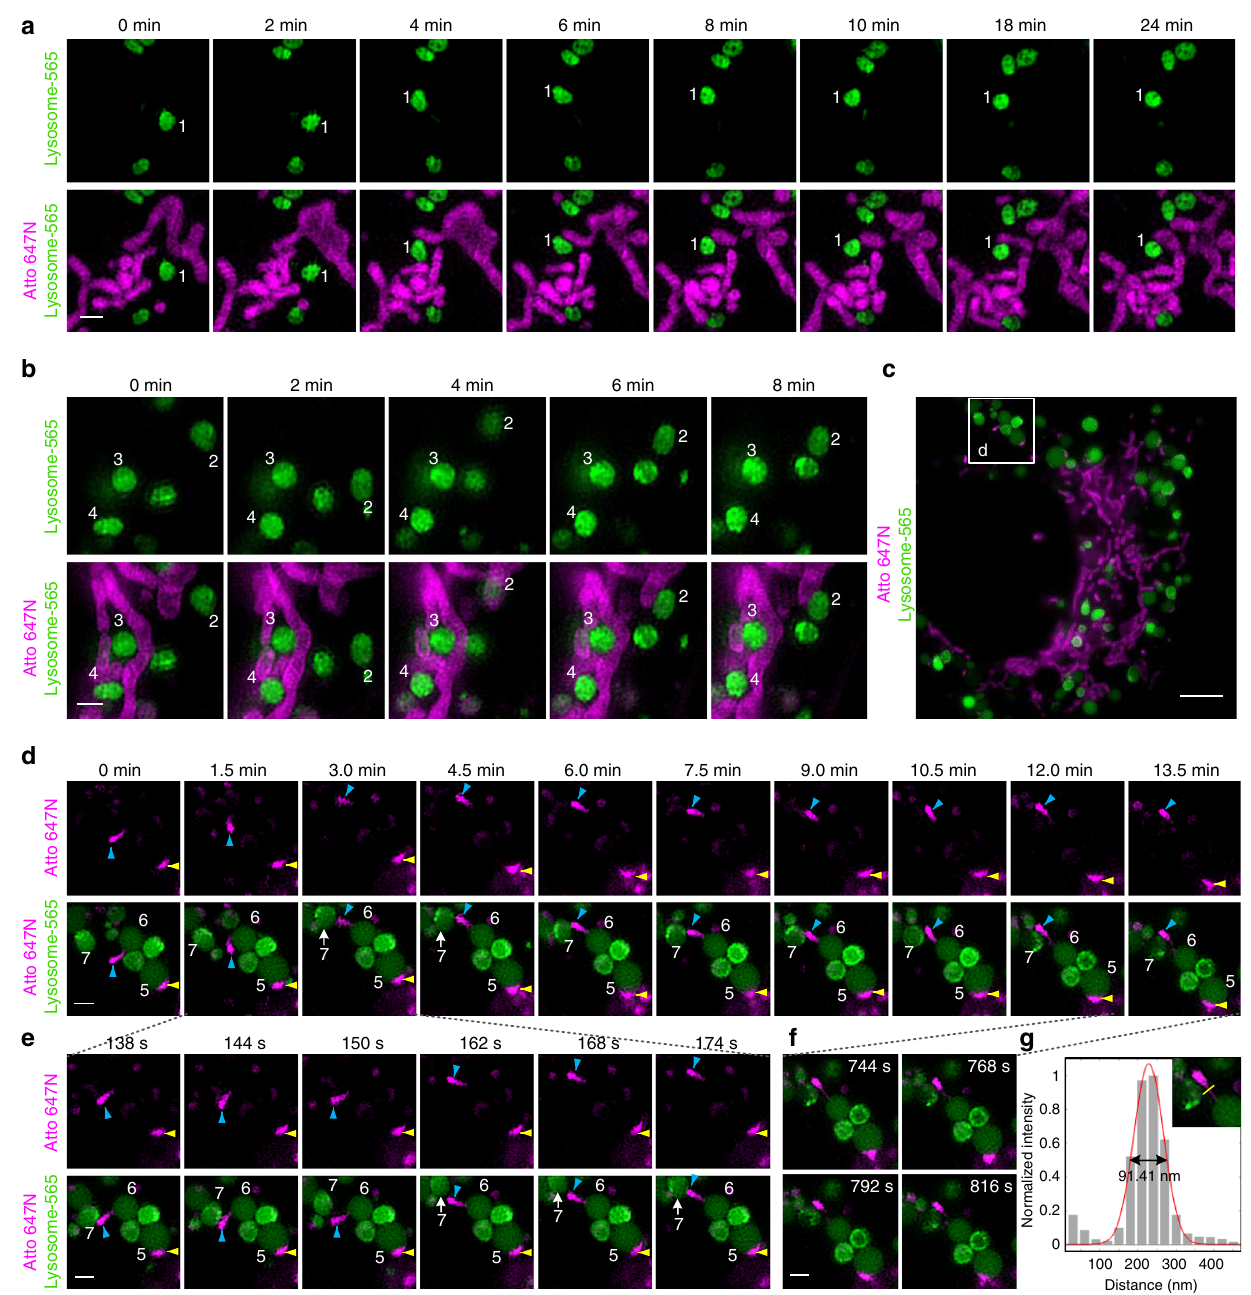
Fig. 3 Dual-color SIM images of lysosomes and mitochondria in live cells. a , b , d , e , f Representative time-lapse SIM images reveal different types of dynamic physical interactions between lysosomes and mitochondria in live U2OS cells stained with Lysosome-565 (green) and Atto 647N (magenta) (more frames are shown in Supplementary Movies 3 – 5). c A SIM image of a whole live U2OS cell. g Cross-sectional pro fi le of the tubular structure of the mitochondrion in f at a full-width at the half-maximum (FWHM) of 91 nm. Each SIM frame was acquired over 270 ms (i.e., a raw data exposure time of 30 ms). For the time-lapse images, the time interval between each dual-color SIM image was set to 6 s. Scale bars, a , b , d , e , f 1 μ m, and c 4 μ